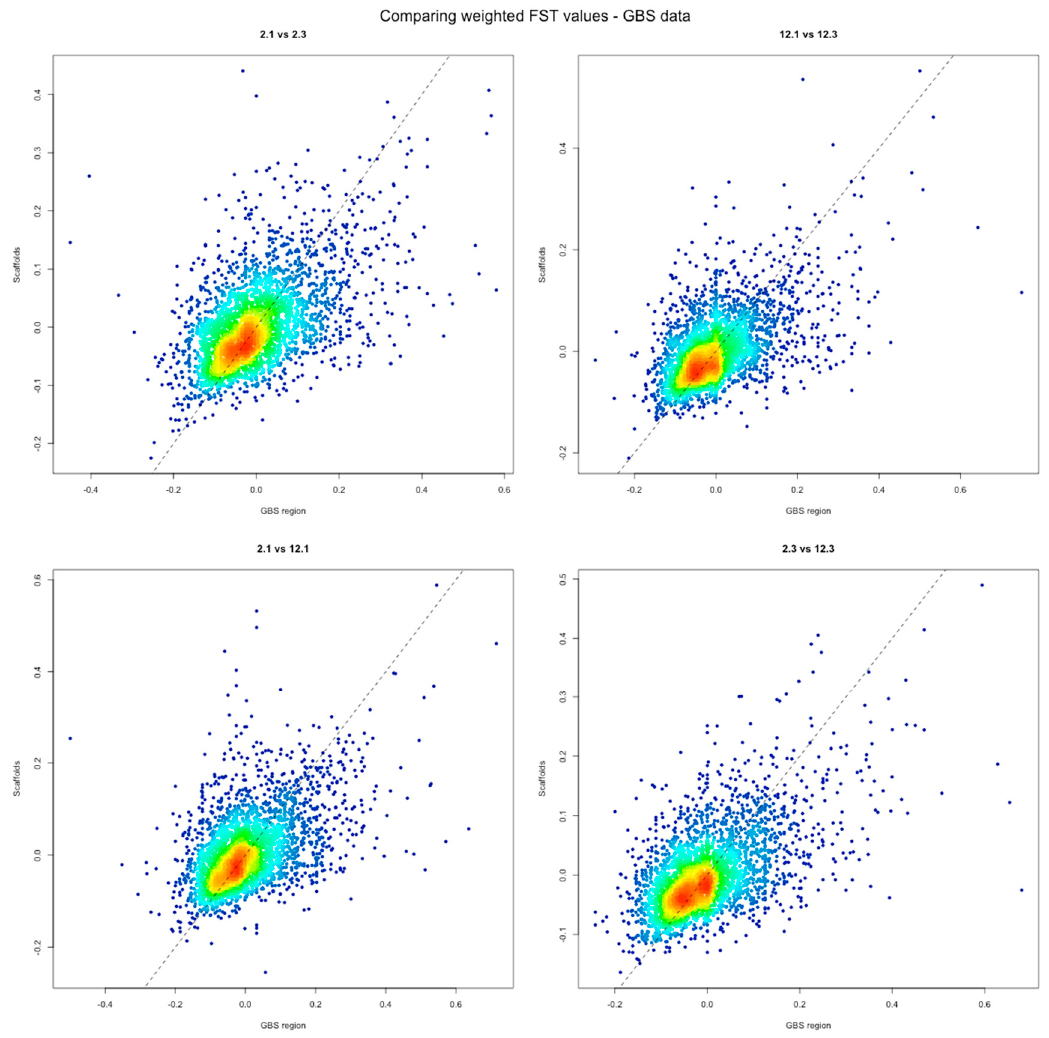
Figure 5. Comparing Fst values between populations in the GBS data. Population 2.1 is an old costal population and 2.3 a young, recently planted costal population. 12.1 is an old population from the mountain region in Västerbotten county and 12.3 is a newly planted population in the mountain region. Red indicates the highest number of data points and dark blue the lowest.